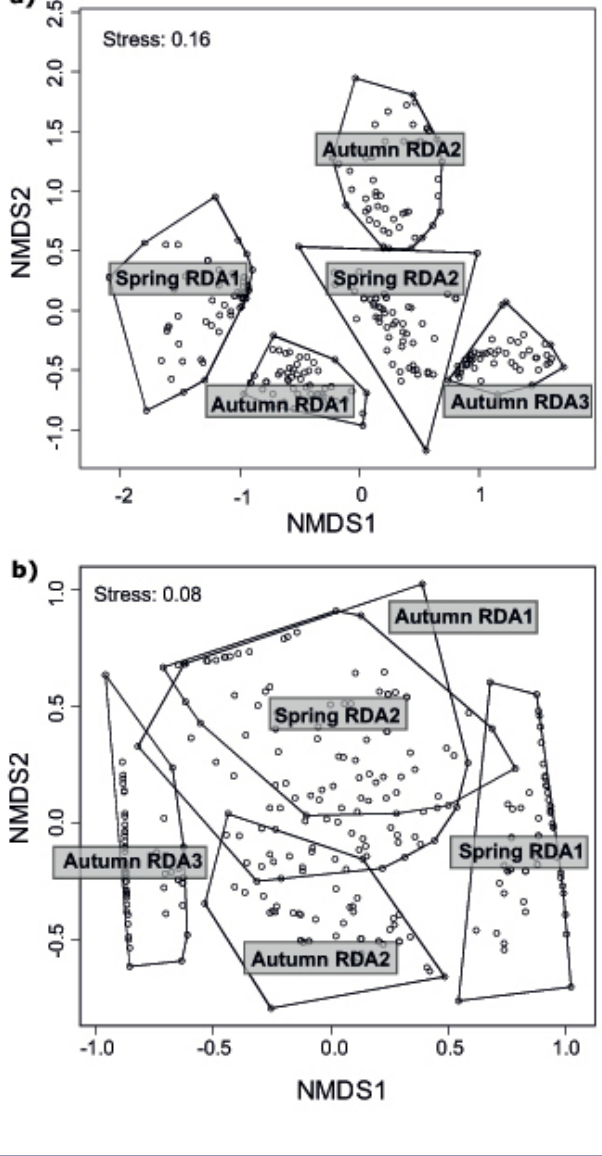
Fig. 2 . Eigenvector maps showing the spatial structures identified at each spatial scale (RDA axis) in (a) spring and (b) autumn. The squares in the maps are equivalent to the spatial location of each sampling site in the Krycklan catchment (as shown in Fig. 1). The color of the squares represents the sign of correlation (white, negative; black, positive), and the size of the squares is proportional to the site scores (numbers under the squares) indicating the strength of correlation.